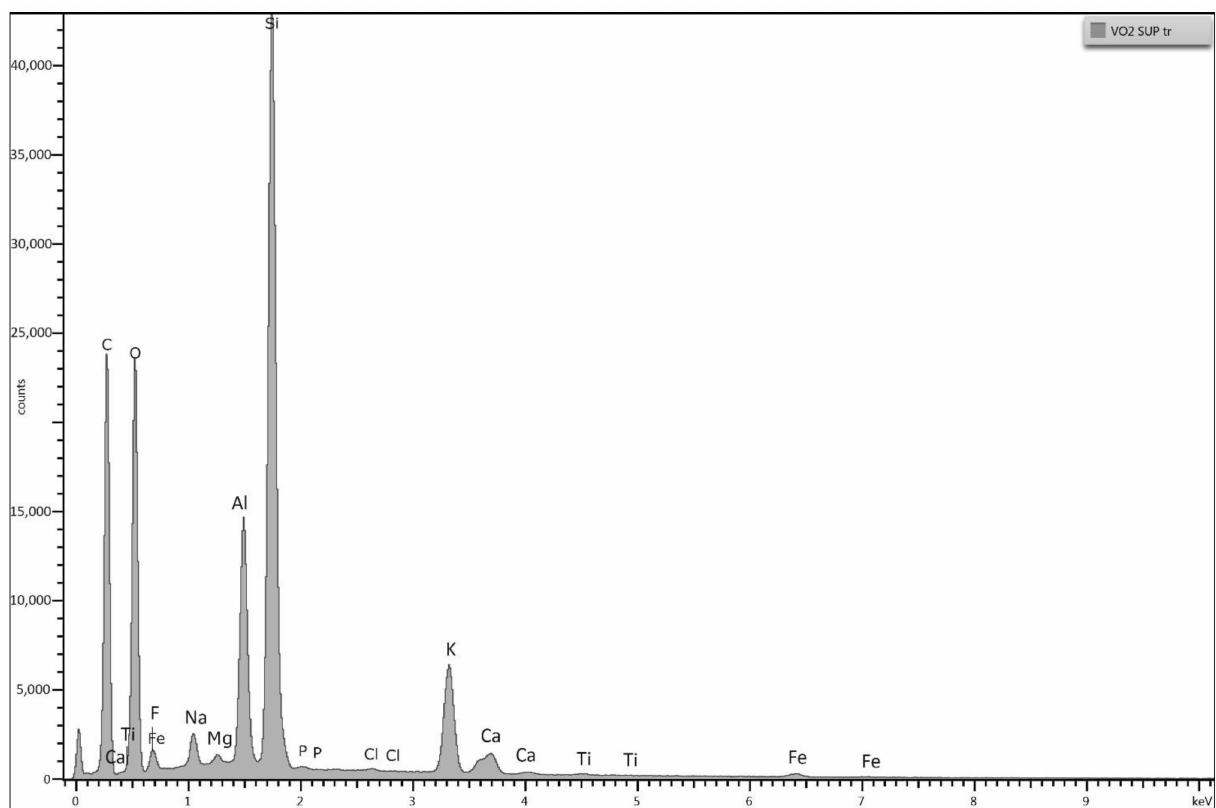
Figure 10. Elemental analysis in SEM-EDS: sample treated with NSW treatment (University of Bari Aldo Moro).